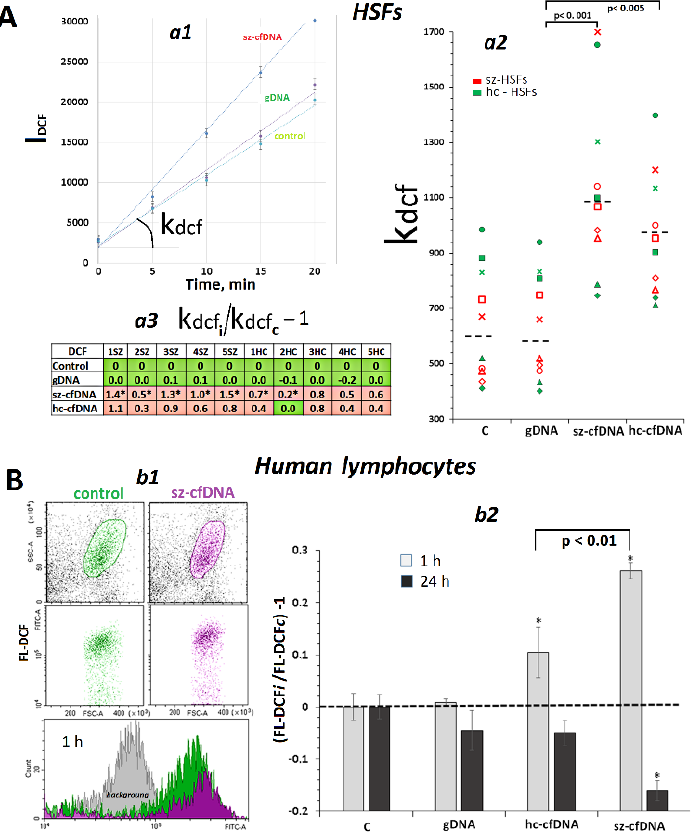
Figure 1. The exposure to cfDNA leads to an increase in ROS production. ( A ). Synthesis of ROS in HSFs, which were incubated for 1 h in the presence of DNA samples (50 ng/mL). a1 —The results of the quantification of fluorescence using plate reader. The time kinetics of fluorescence outputs in cells treated with H 2 DCFH-DA. The data from the device are given for sz-HSF3. a2— Change of the k dcf in the presence of DNA samples. The DNA samples are indicated on the graph; medians—dotted lines. a3 —Analysis of relative changes in ROS levels in the presence of DNA samples compared to control. Green color—no significant differences with the control ( p > 0.01), red—increased RNA content in the presence of the DNA sample ( p < 0.01). (*) the response to sz-cfDNA differs from the response to hc-cfDNA for this HSF ( p < 0.01). ( B ). Synthesis of ROS in PBL, which were incubated for 1 and 24 h in the presence of DNA samples. b1 —The most typical examples of ROS assay with FCA in PBL. b2 —Change of the ROS level in PBL in the presence of DNA samples (50 ng/mL). Average values for four lymphocyte samples and the standard deviation are given. (*)—the differences with the control are significant ( p < 0.01).